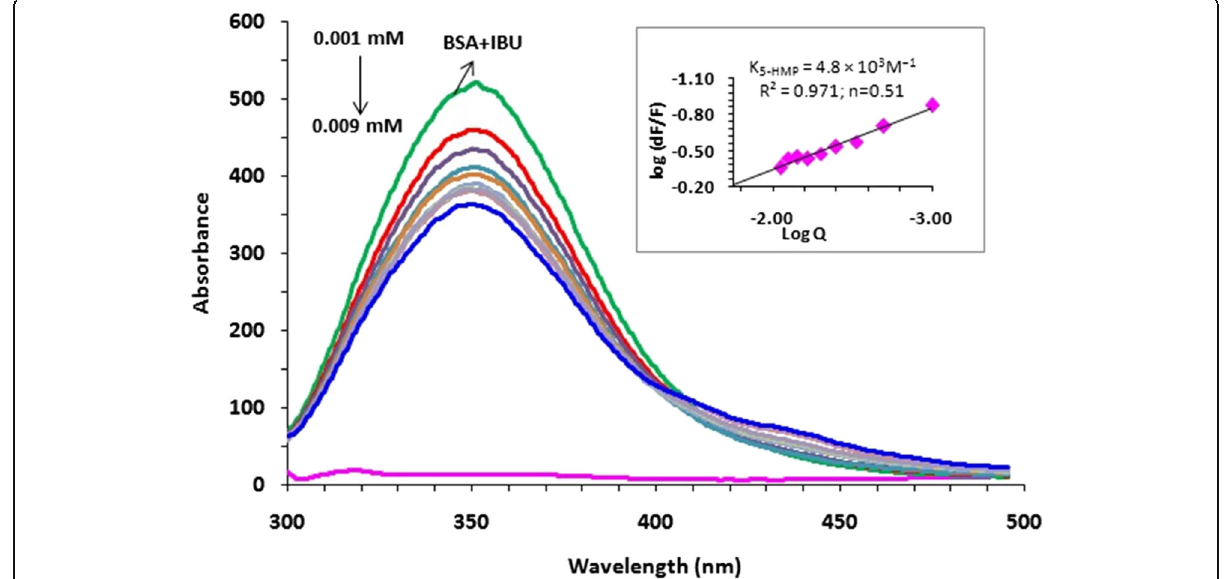
Fig. 6 Displacement experiment of BSA-5-HMP complexes with site-specific markers ibuprofen complex by 5-HMP (0.001 to 0.009